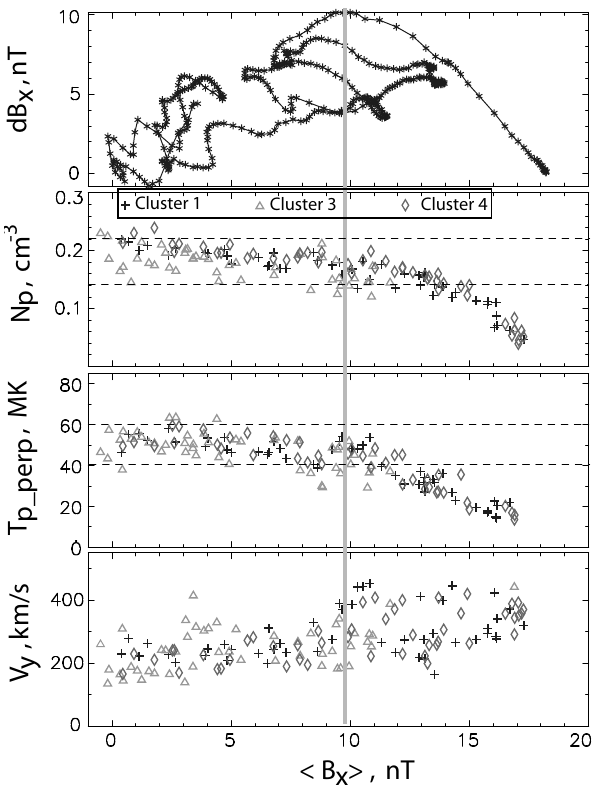
Fig. 5. Distributions of magnetic field difference ( DB x ), plasma density, perpendicular temperature and Y -component of bulk ve- locity versus h B x i during interval C (see explanations in the text).